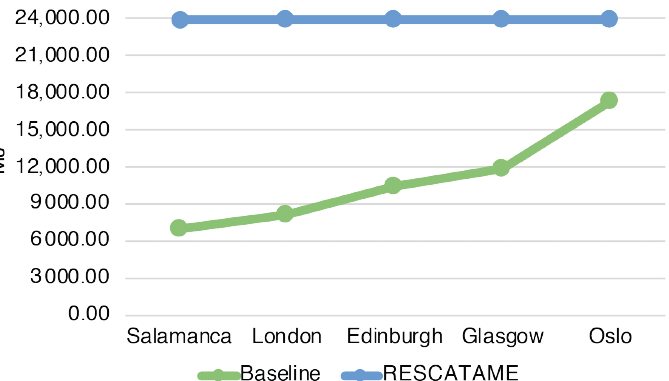
Figure 11. Energy impact comparison between the RESCATAME implementation and the green solution in the different cities of installation.